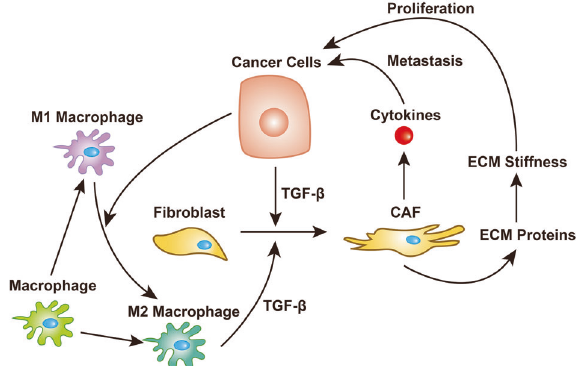
Fig. 2 The signaling loop formed by cancer cells, macrophages and fi broblasts contributes to ECM stiffness, in which TGF- β plays a